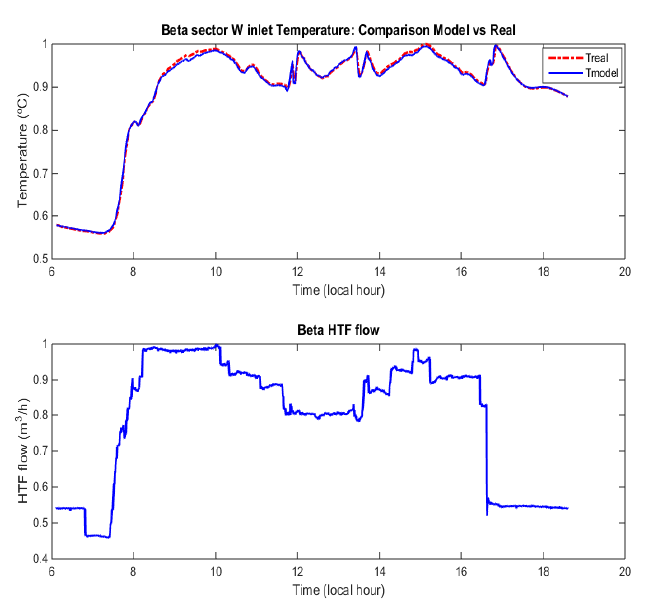
Figure 12. Mojave Beta, inlet temperature of the west sector: ( top ) model (solid blue) and real (red dash-dotted); and ( bottom ) HTF flow.